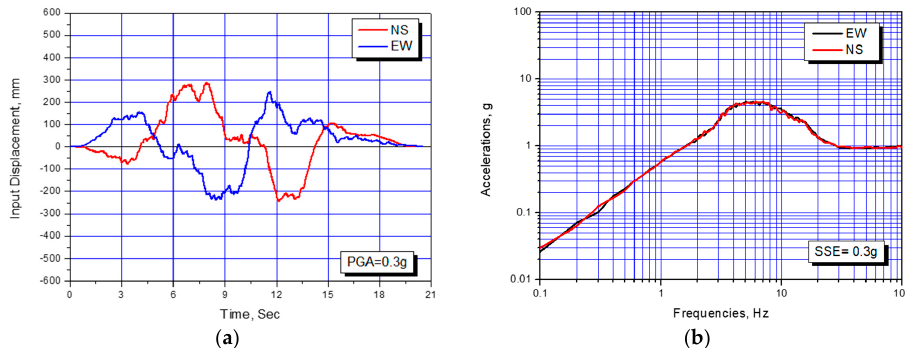
Figure 4. Used seismic input motion PGA (Peak Ground Acceleration) = 0.3 g: ( a ) displacement; ( b ) floor response spectrum.